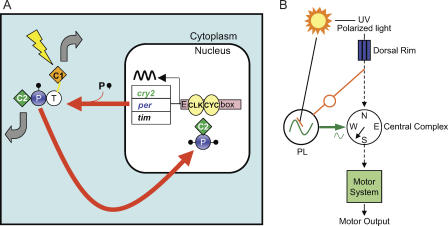
Proposed Monarch Butterfly Circadian Clock Mechanism and CRY-Centric Clock-Compass Models(A) The main gear of the clock mechanism in pars lateralis is an autoregulatory transcription feedback loop in which CLK and CYC heterodimers drive the transcription of the per, tim, and cry2 genes through E box enhancer elements; in addition to per, there are CACGTG E box elements within the 1.5-kb 5′ flanking regions of the butterfly tim and cry2 genes (unpublished data). TIM (T), PER (P), and CRY2 (C2) form complexes in the cytoplasm, and CRY2 is shuttled into the nucleus where it shuts down CLK:CYC–mediated transcription. PER is progressively phosphorylated and likely helps translocate CRY2 into nucleus. CRY1 (C1) is a circadian photoreceptor, which, upon light exposure (lightning bolt), causes TIM degradation to gain access to the central clock mechanism. The thick gray arrows represent output functions for CRY1 and for CRY2.(B) Clock-compass pathways in monarch butterfly brain. A circadian clock in the PL is entrained by light acting through CRY1 expressed in clock cells (orange line). A CRY1-positive fiber pathway (orange) connects the circadian clock to axons originating from polarized UV light-sensitive photoreceptors in the dorsal rim of the compound eye [13, 45]. The circadian clock also may interact directly with the sun compass (in the central complex) through a CRY2-positive fiber pathway (green) discovered in the current study. Output from the central complex ultimately controls motor output.